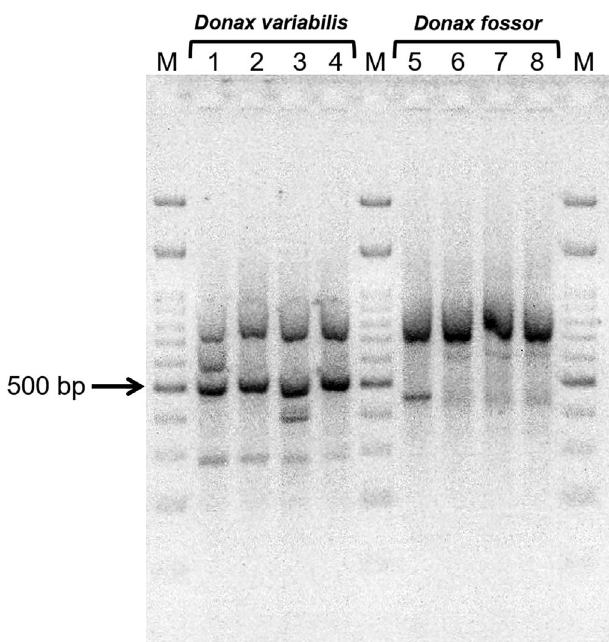
Figure 7. RAPD ampli fi cations generated using primer E18 on a 2% agarose gel alongside a 100-base pair (bp) ladder (M). Lanes 1 – 4 are ampli fi cations from individuals of Donax variabilis , and lanes 5 – 8 are from individuals of D. fossor . Only D. variabilis individuals produced the 500-bp diagnostic